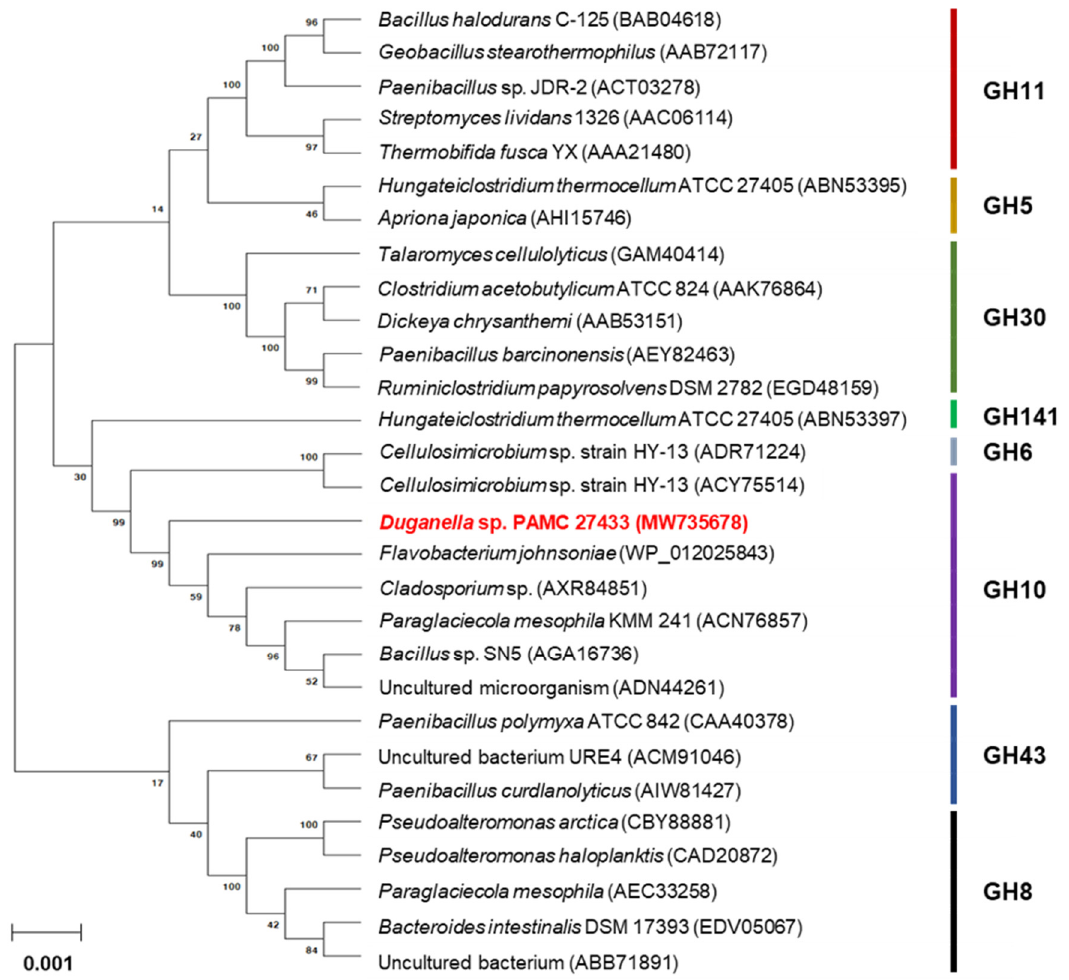
Figure 2. Phylogenetic analysis of Duganella sp. PAMC 27433 GH10 endo- β -1,4-xylanase (XylR) and its closely related functional homologs. Alignment of the amino acid sequences was carried out using ClustalW in the MegAlign program (DNASTAR Inc., Madison, WI, USA). The protein sequences employed for phylogenetic analysis were retrieved from the GenBank